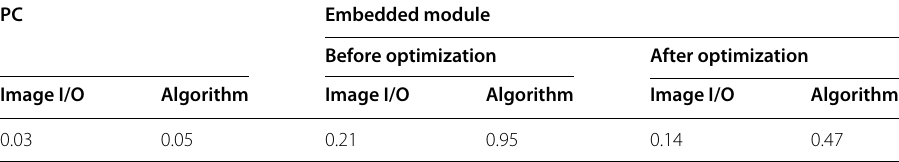
Table 6 Comparison of processing time of PC and embedded module PC Embedded module Before optimization After optimization Image I/O Algorithm Image I/O Algorithm Image I/O Algorithm